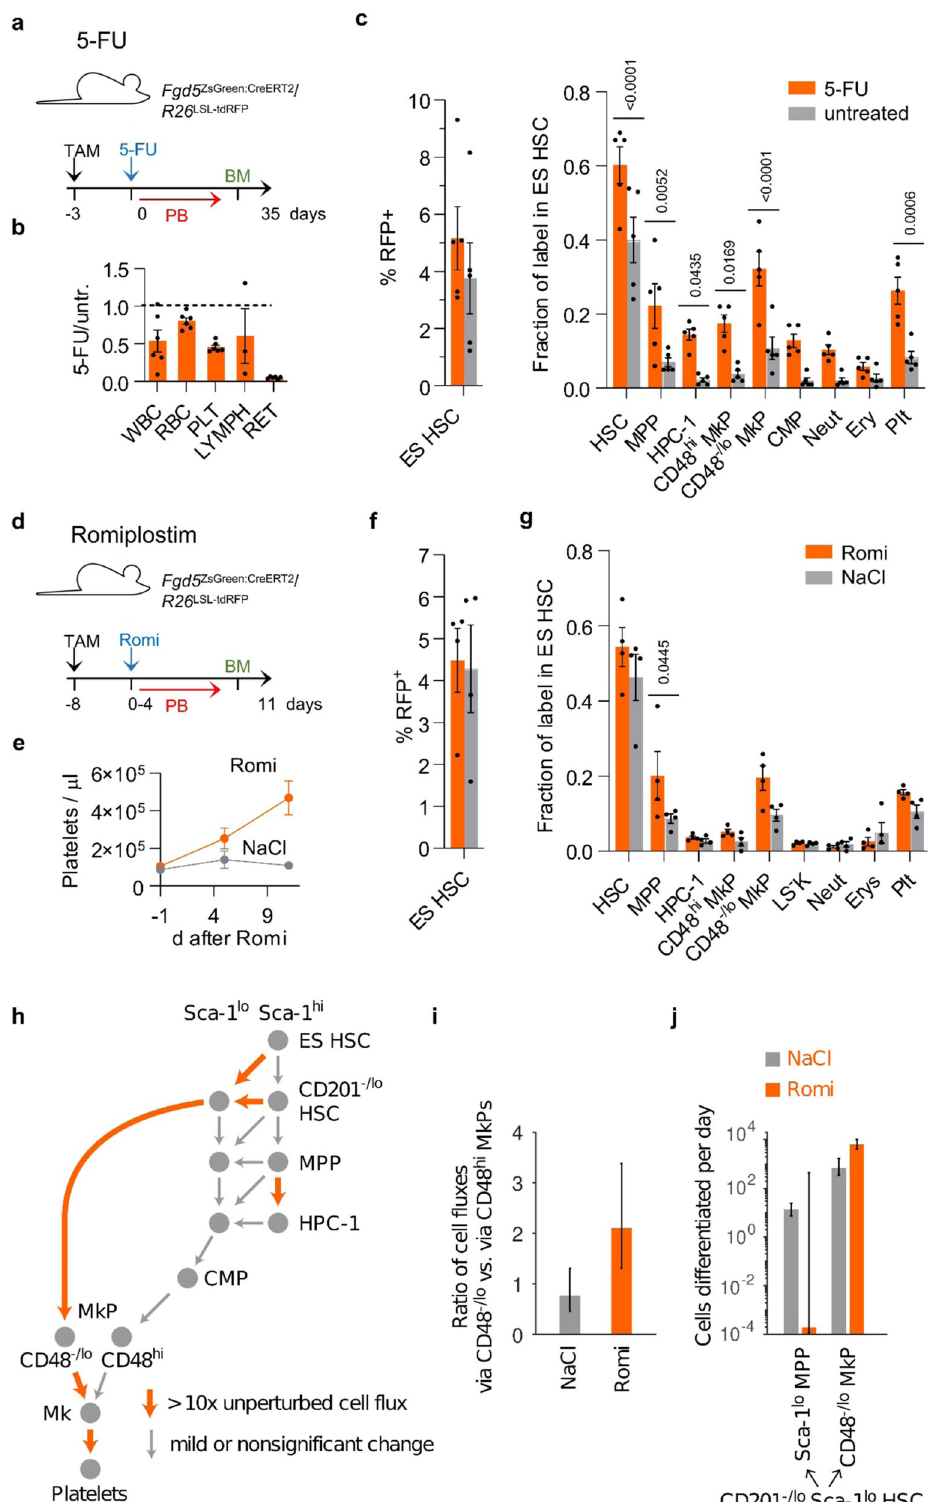
Fgd5 ZsGreen:CreERT2 /R26 LSL-tdRFP -animals, or 3. anti-Streptavidin (eF710, 1:200, eBioscience), anti-CD117(c-kit) (APC/eF780, clone 2B8, 1:1600, eBioscience),